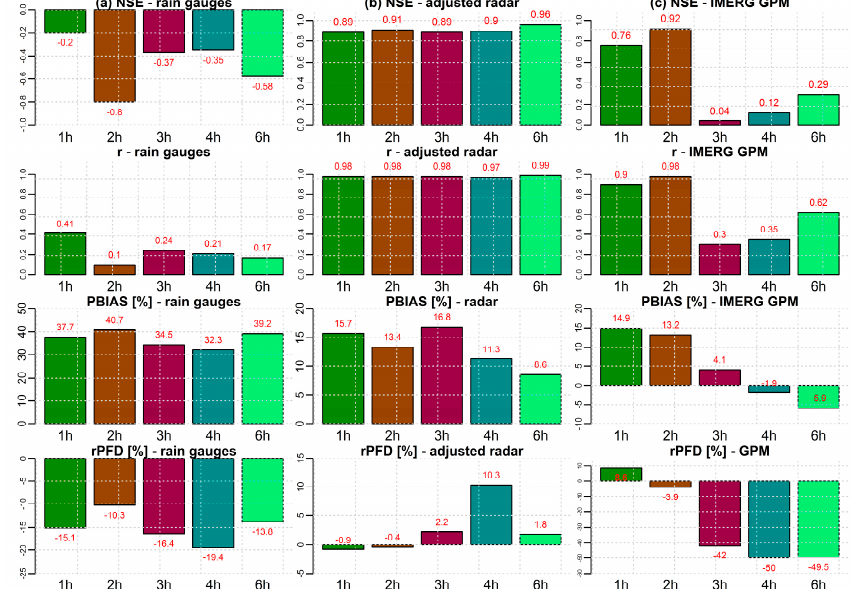
Figure 10. Comparison of the evaluation metrics performance (in columns) for Event 5 for aggregated time-steps simulations based on ( a ) rain gauge precipitation, ( b ) adjusted radar rainfall estimates, ( c ) IMERG GPM satellite rainfall estimates.